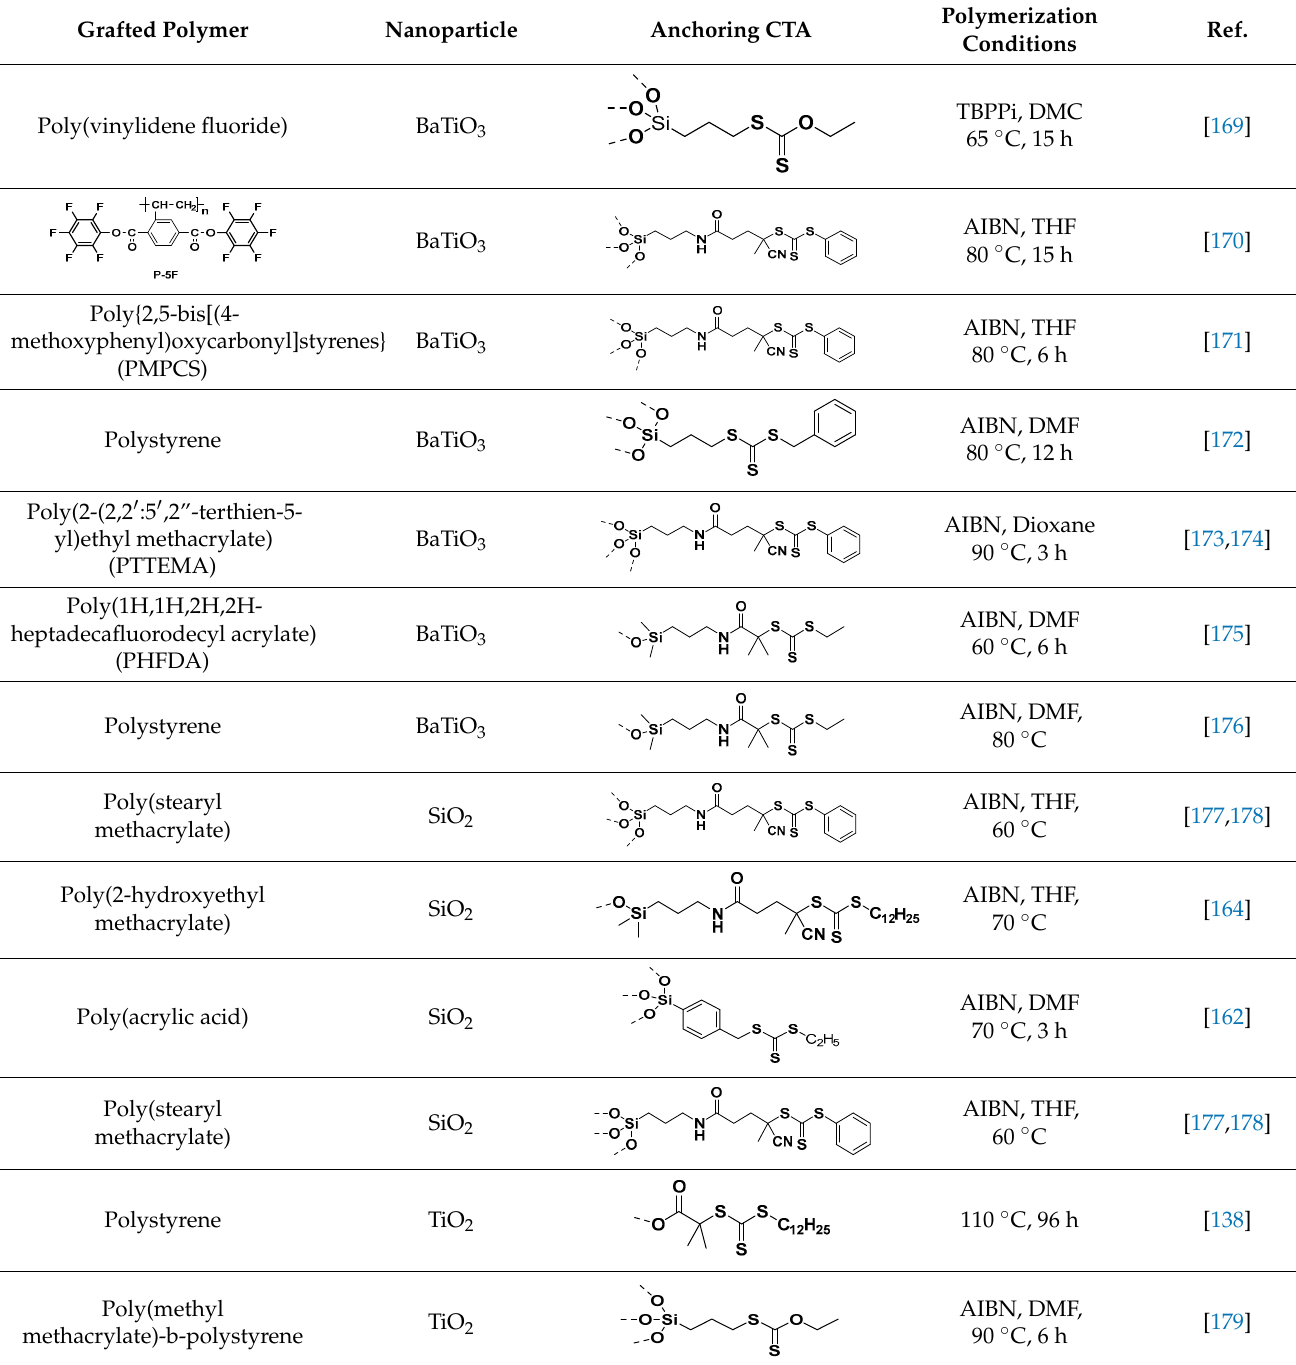
Table 6. Details about various polymer grafted nanoparticles using SI-RAFT.